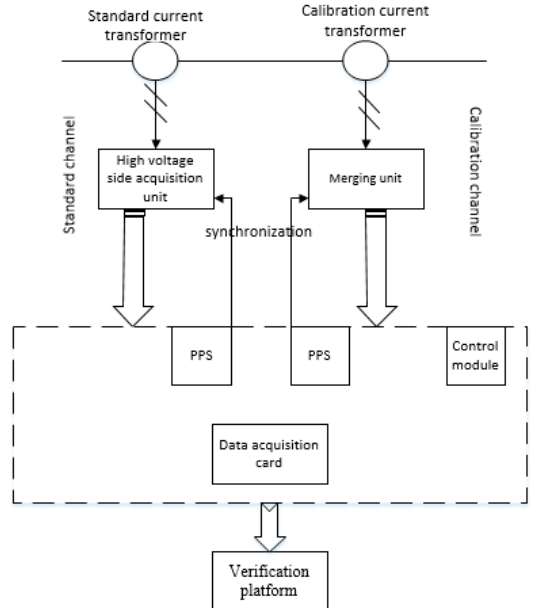
Figure 1. Schematic diagram of the online verification principle for current sensors.